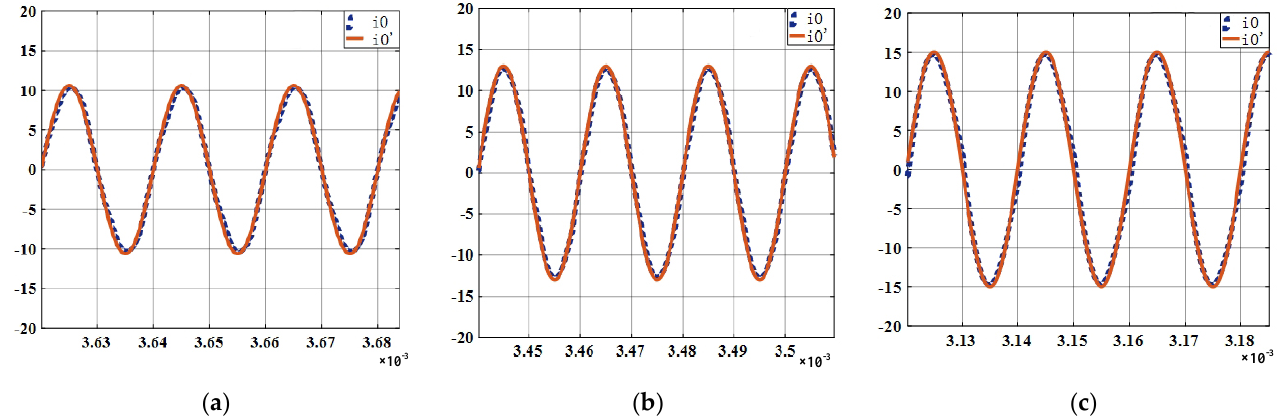
Figure 3. Waveforms of i0 and i 0′ at each conduction angle of the input voltage. ( a ) Voltage conduction angle 90°; ( b ) Voltage conduction angle 120°; ( c ) Voltage conduction angle 180°. Table 1. WPT system simulation and experimental